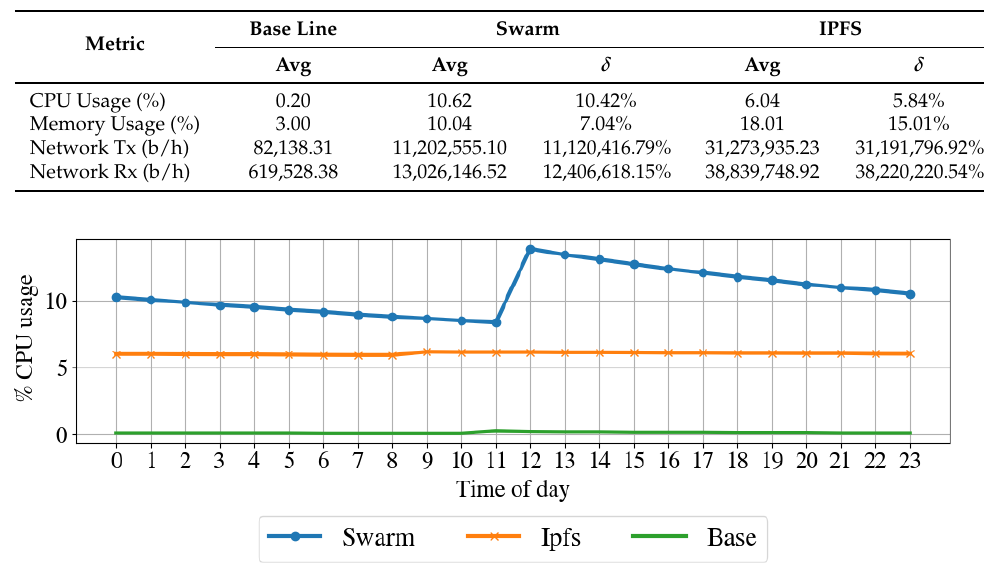
Figure 10. System average CPU usage before and while running the proposed architecture with IPFS and Swarm.